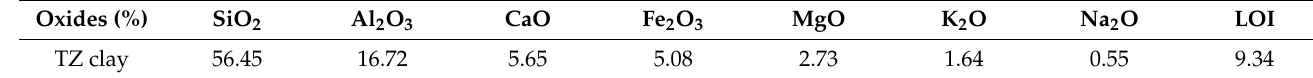
Table 4. Oxide composition of TZ clay.